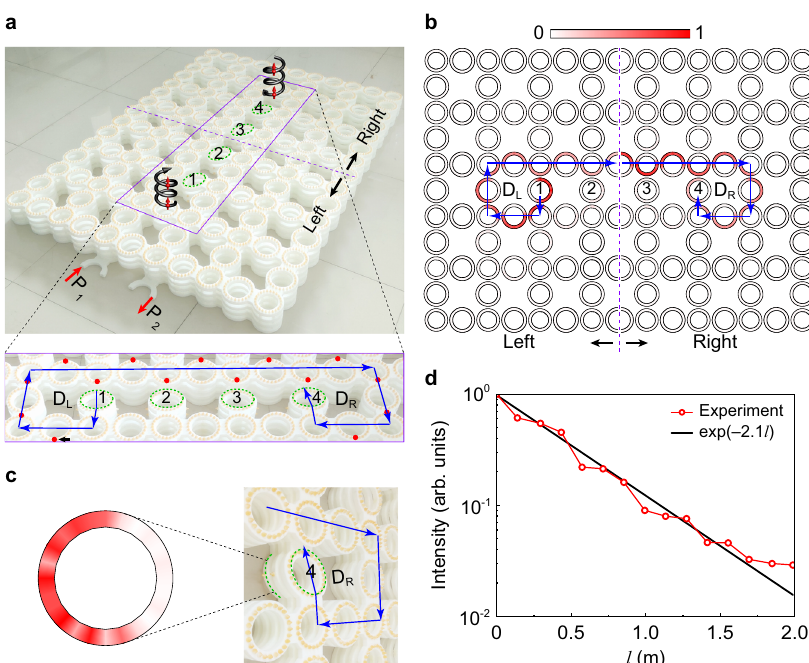
Fig. 4 Experimental observation of the unidirectional sound routing in a dislocation loop. a Experimental sample. The inset gives more details around the dislocations, where D L and D R label the positions of the screw dislocations, and the blue arrows point to the propagation of the pseudospin-up TDMs excited by the sound source at the port P 1 . b Pressure amplitude distribution scanned on the top layer at 6.27 kHz. c Pressure amplitude distribution measured for the lowest ring-waveguide around the screw dislocation D R . d Sound intensity (red circles) extracted along the dislocation path on the top layer, whose shape is captured well again by exp ð(cid:3) 2 : 1 l Þ (black interlayer coupler adjacent to the dislocation, i.e., the tilted ring- waveguide 1 and the associated straight tubes. In this case, the TDMs will be coupled to the top layer through the tilted ring- waveguide 2. To con fi rm this point, we have experimentally scanned the pressure fi eld on the top layer of the sample. Figure 3f exempli fi es the data at 6.27 kHz. As predicted in Fig. 2f, the sound fi eld bypasses the defect and propagates along the prescribed path like the system without the defect. To quantitatively characterize the topological robustness of the TDMs against the pseudospin-preserved defect, we have further extracted and compared the sound energy spectra at the positions highlighted in Fig. 3b (the red dots with black arrows) for the systems without and with a defect. As shown in Fig. 3g, the sound intensity spectra of the two systems (black and red circles) deviate with each other over the entire frequency range. However, if the dissipation induced by the extra propagation length of the TDMs is compensated, the spectrum of the defect system (blue circles) inside the nontrivial gap (highlighted in yellow) exhibits almost the same magnitude with that of the perfect system (red circles).